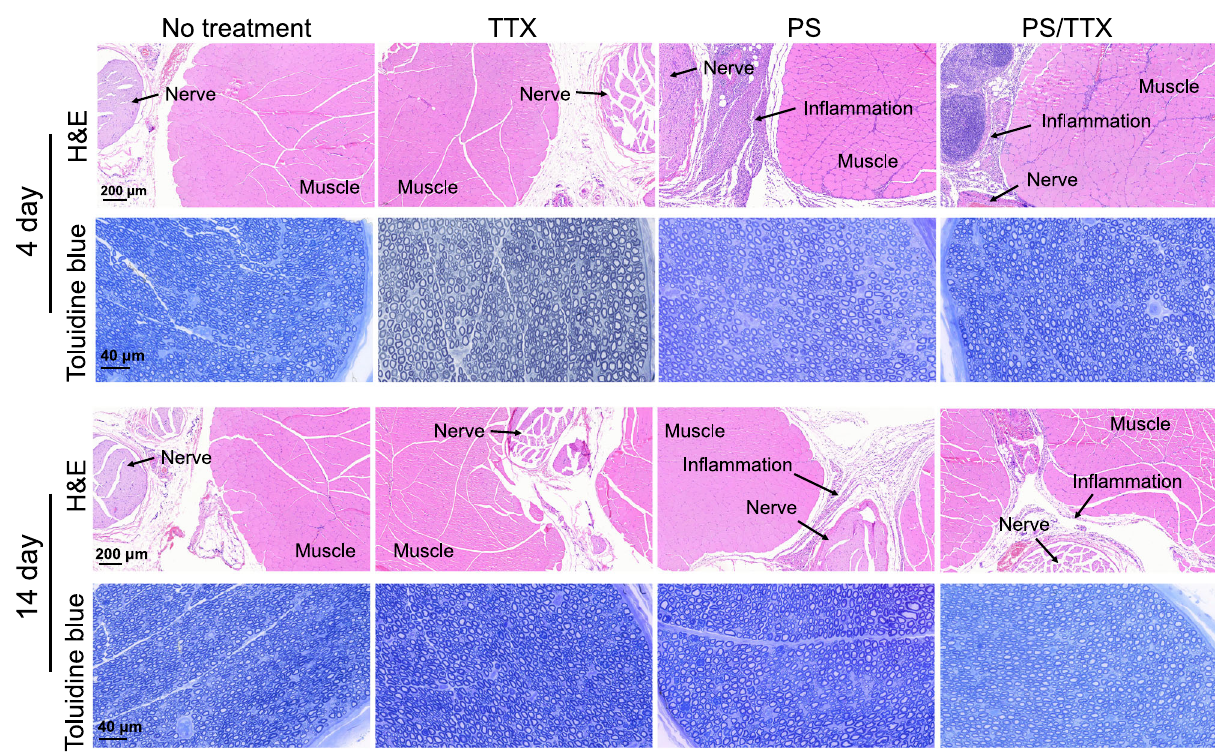
Fig. 4 | Tissue reaction to free TTX, PS aptamer, and PS/TTX complexes. H&E: Representative hematoxylin – eosin stained sections of muscles and adjacent loose connective tissue 4 and 14 days after sciatic nerve injection of TTX (52 μ M), PS